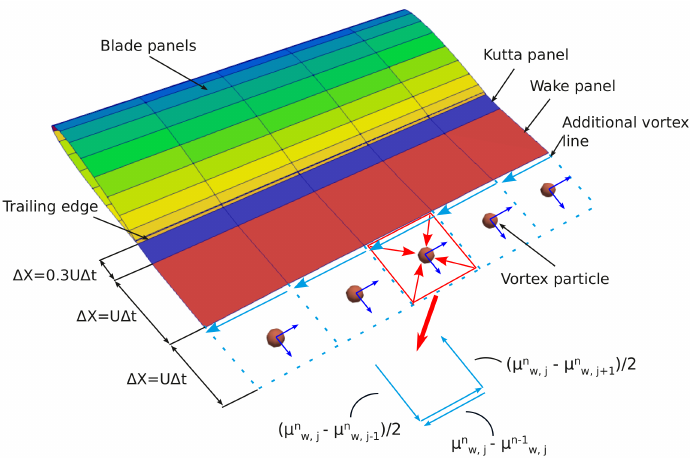
Figure 1. A description of the conversion of the wake doublet panel to vortex